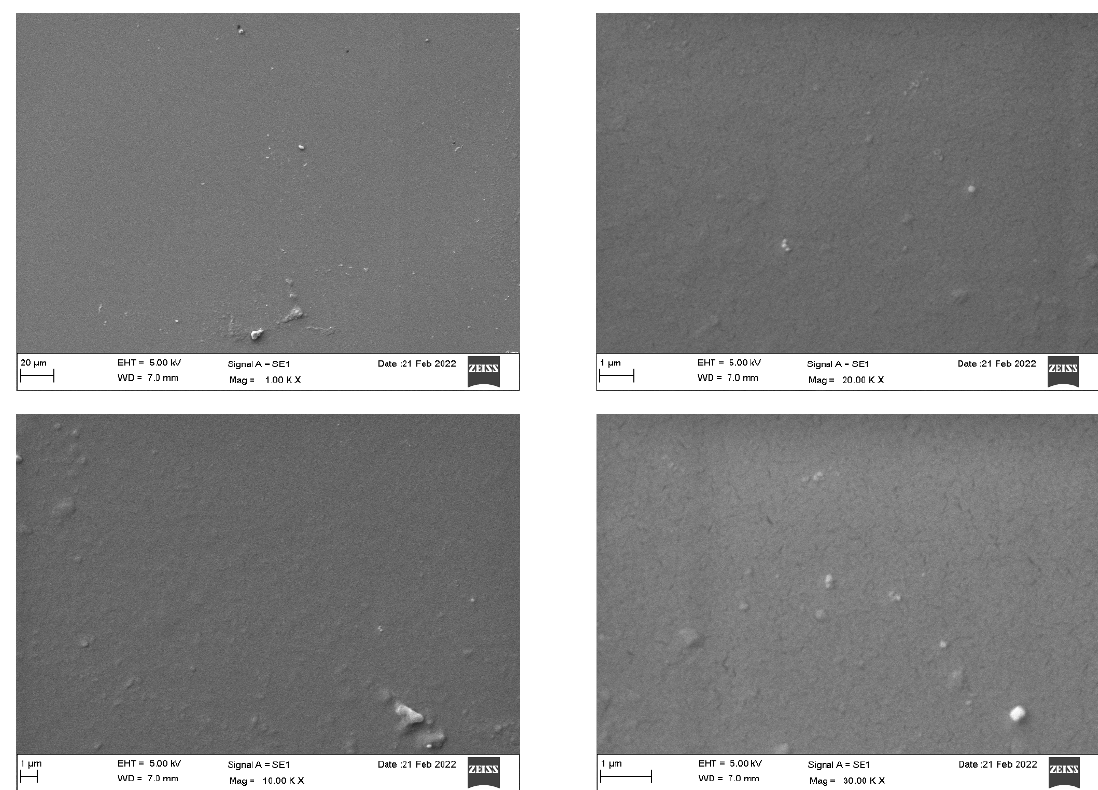
Figure 3. Scanning electron microscopy of the Invisalign ® system .